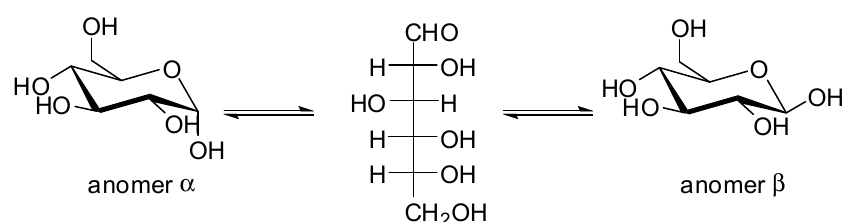
Figure 8. Mutarotation of D-glucose.